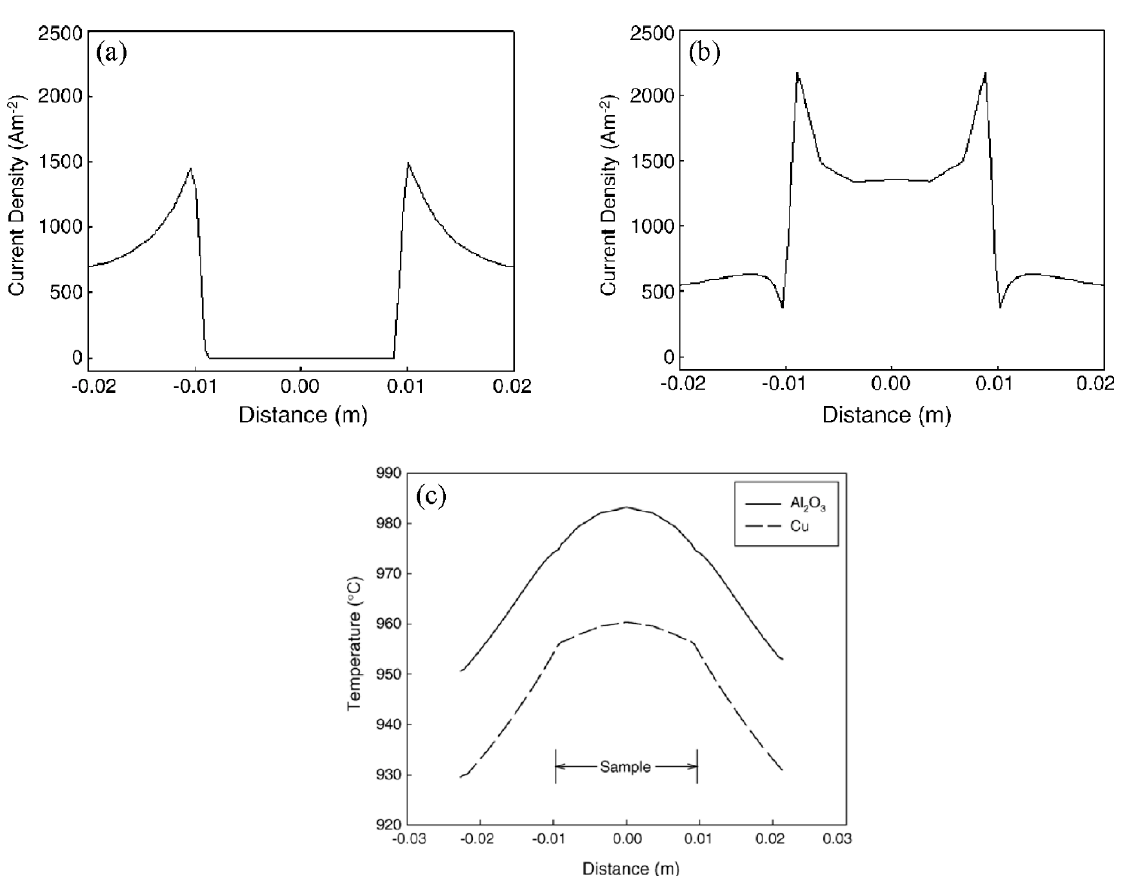
Figure 13. FEM simulations of two SPS setups, compared with metallographic observations of the center and edge of TiAl samples. For setup ( a ), the microstructure of the center is duplex ( b ), and that of the edge is near- γ with some remaining porosities ( c ). This indicates a temperature gradient between the center and the edge of the sample of about 100 °C, in reasonable agreement with the FEM modeling ( a ), which predict a gradient of 125 °C. For setup ( d ), the FEM simulation predicts a temperature gradient between center and edge of the samples of 30 °C. The corresponding microstructures are near lamellar at the center ( e ) and duplex at the edge ( f ), indicating a thermal gradient of 25–50 °C, close to the simulations [74]. Reproduced with permission from Journal of Materials Processing Technology , published by Elsevier, 2013. In summary, the temperature distribution throughout samples during SPS can be ac- curately predicted with FEM. Indeed, it is a necessary tool for designing molds that min- imize thermal gradients and increase the microstructure homogeneity while limiting more expensive and time-consuming experimental testing.